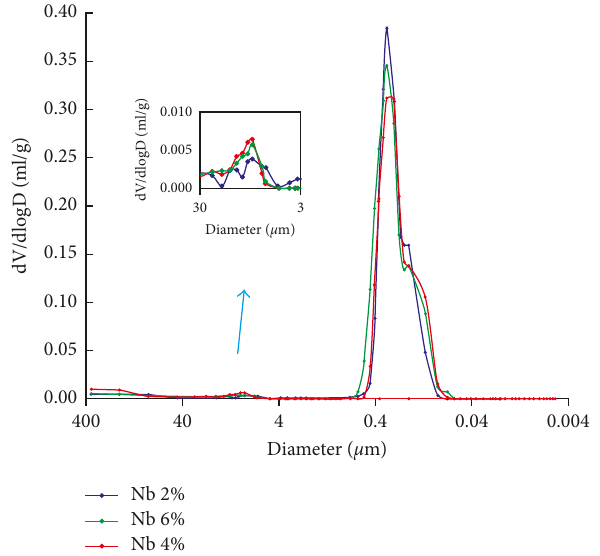
Figure 2: Log differential intrusion as a function of pore diameter of the TiO 2 : WO 3 -doped samples with 2, 4, and 6% of Nb 2 O 5 (inset: macropore region